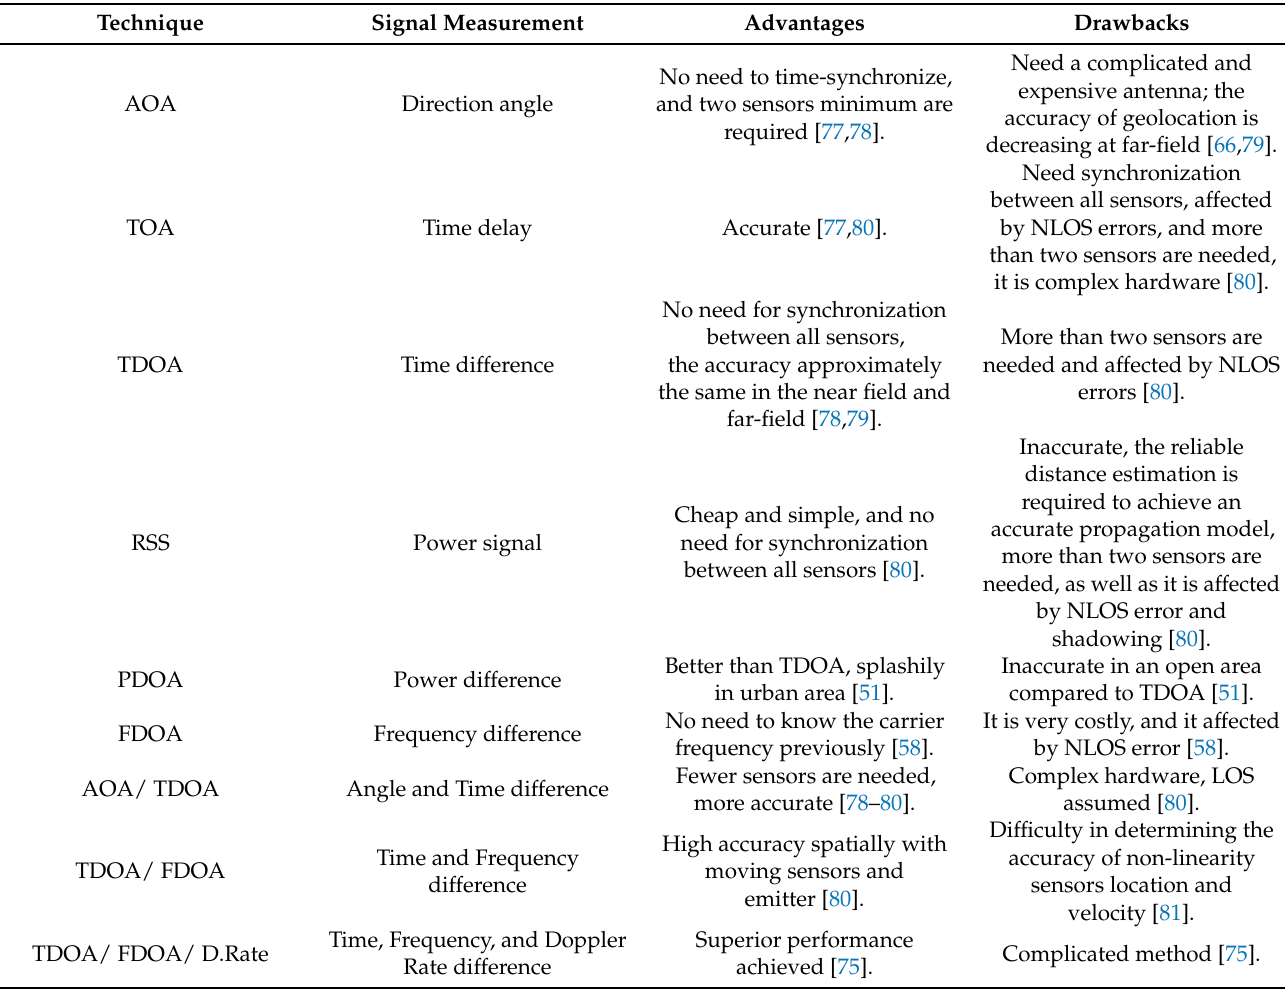
Table 2. Comparison between numerous conventional geolocation